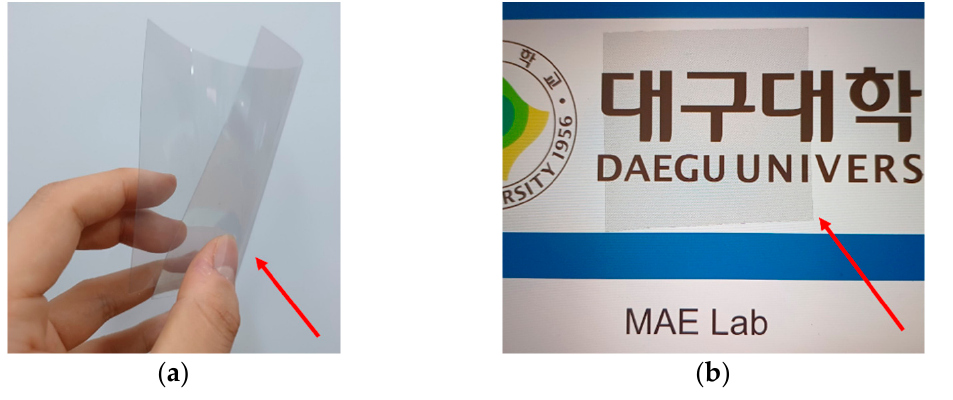
Figure 8. Metal mesh film characteristics. ( a ) Flexibility. ( b ) Transparency.